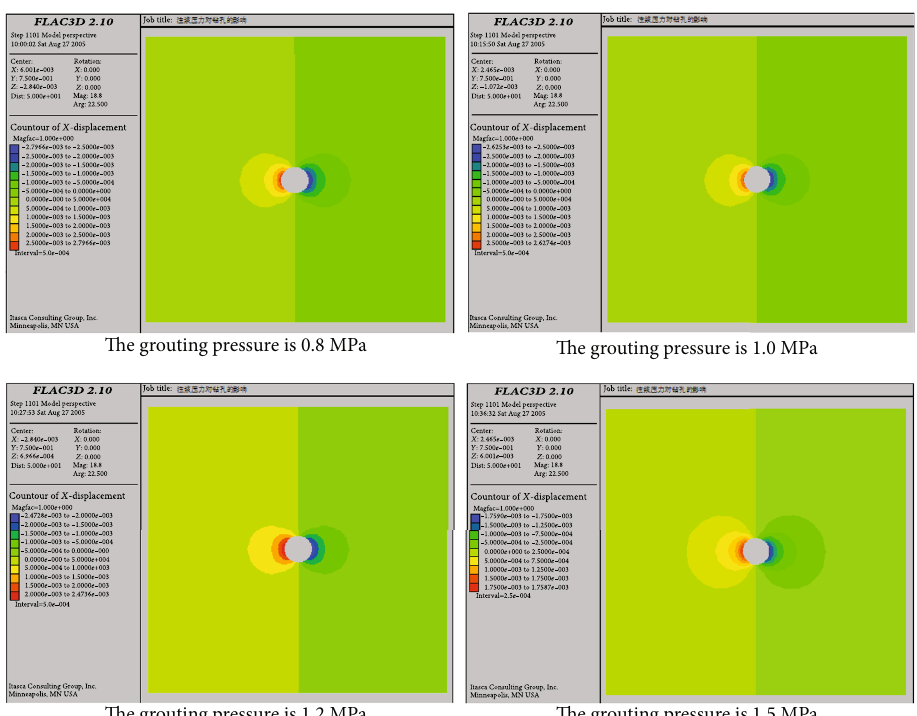
Figure 3: Displacement distribution in the X